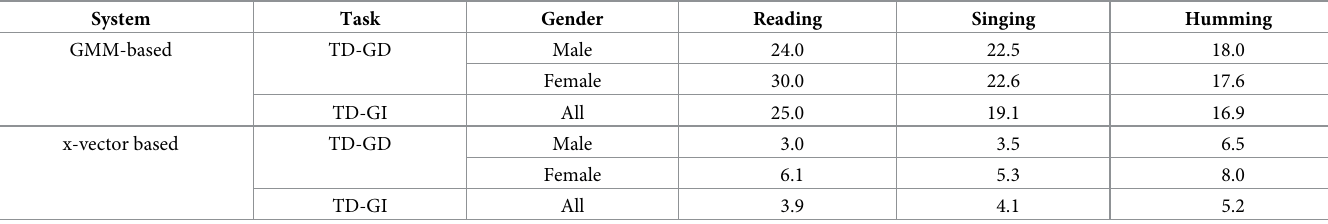
Table 3. EER% on the text-dependent ASV tasks, using three types of single-speaking styles recordings. System Task Gender Reading Singing